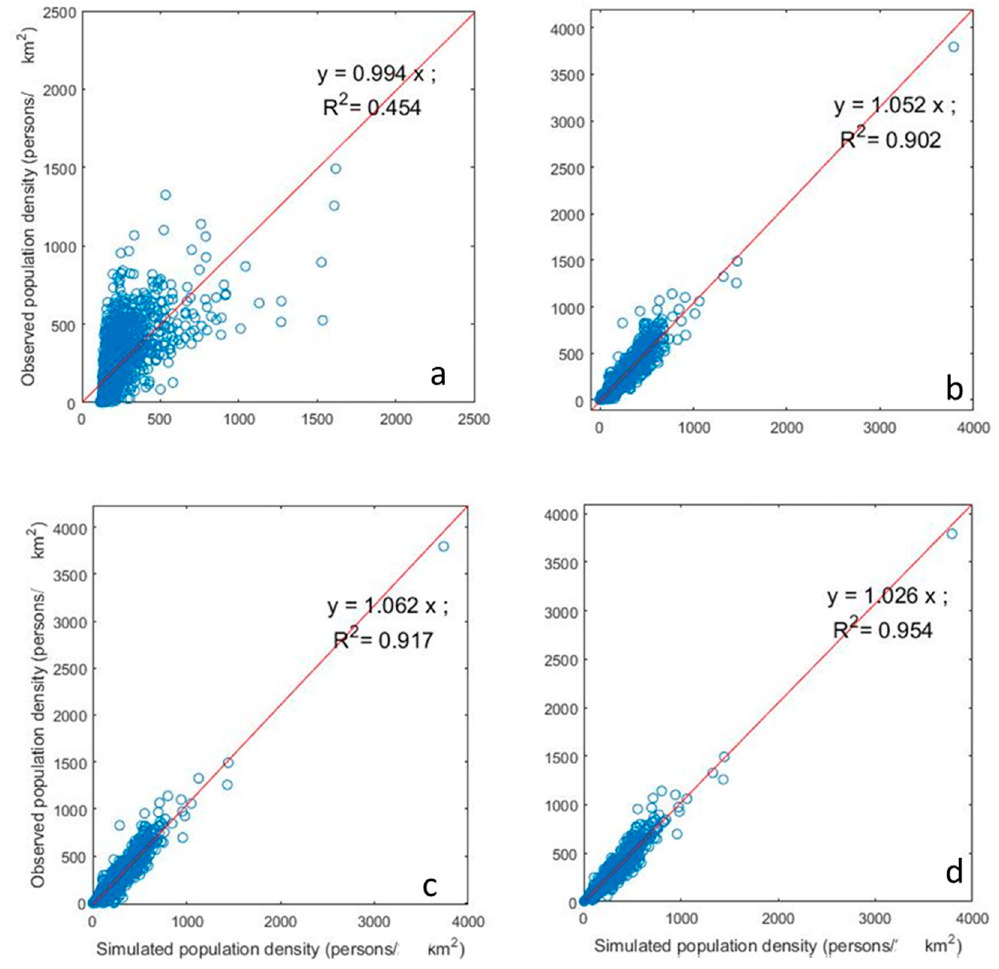
Figure 5. Simulation and observation population density plots from ( a ) OLS, ( b ) GWR, ( c ) NNGWR, and ( d ) ANNGWR in 2007.